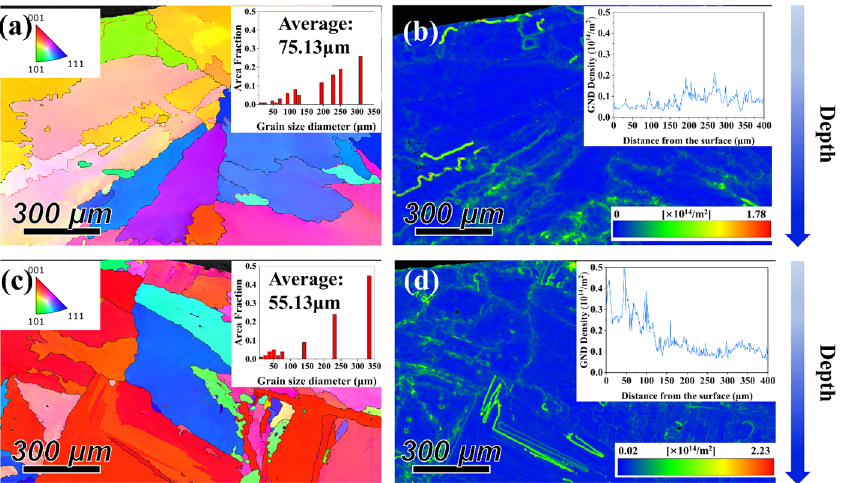
Figure 10. Microstructural characteristics of weld zone of combustion liner weld with LSP and UN-LSP: ( a ) IPF mapping with UN-LSP, ( b ) GND density mapping with UN-LSP, ( c ) IPF mapping with LSP, and ( d ) GND density mapping with